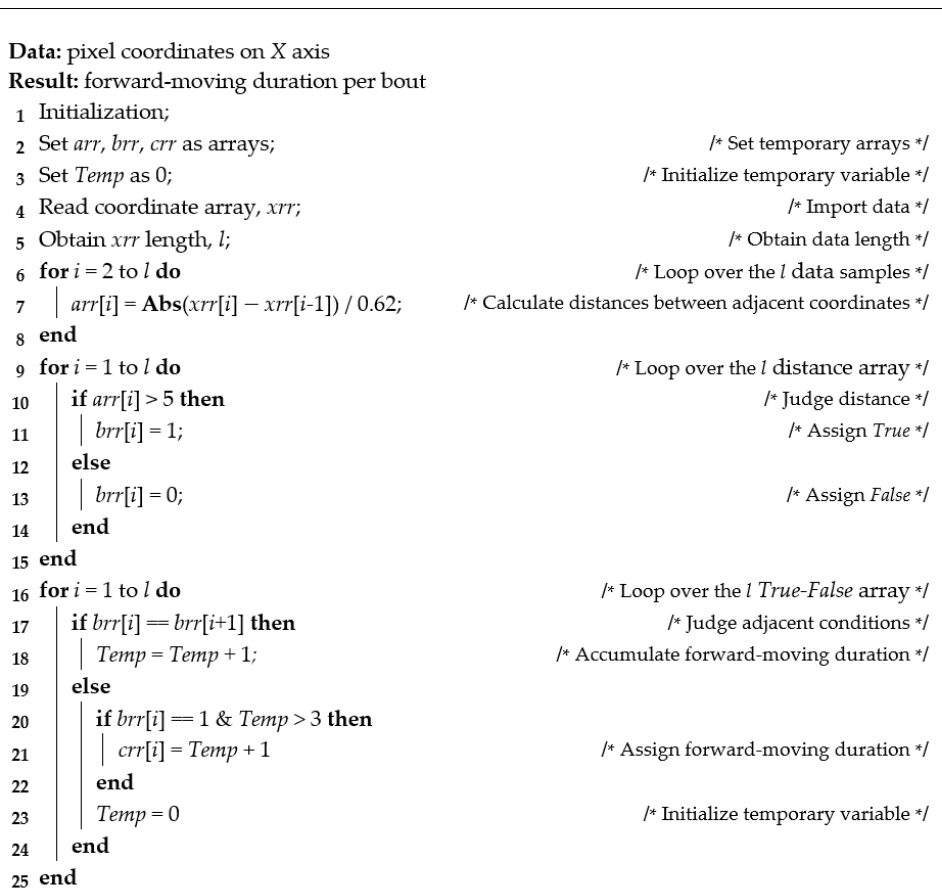
Algorithm 1: Calculating forward-moving duration per